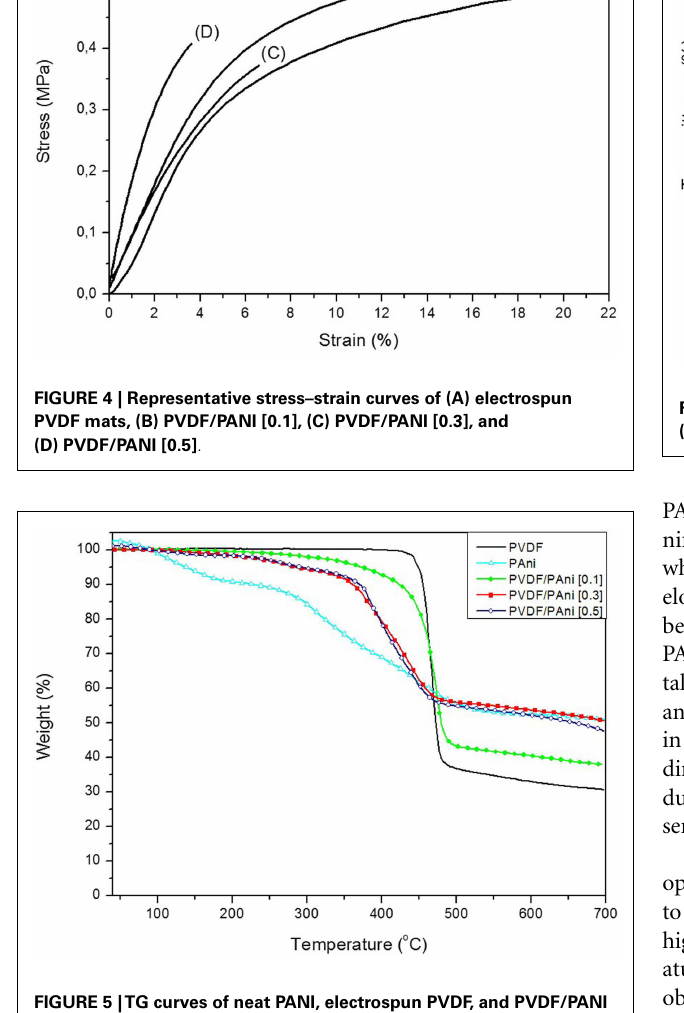
FIGURE 5 |TG curves of neat PANI, electrospun PVDF, and PVDF/PANI mats prepared with differentANI concentrations .